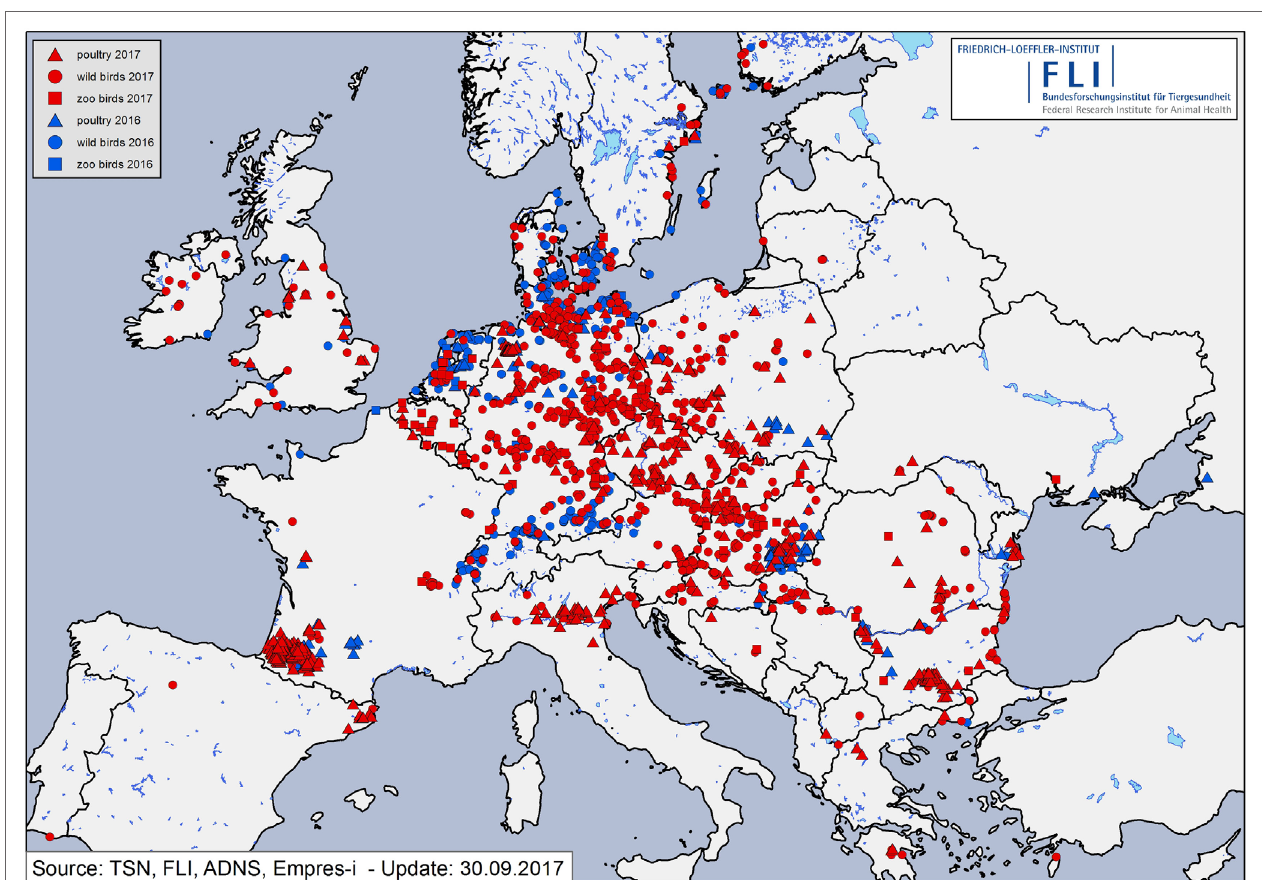
FigUre 2 | Distribution of reported highly pathogenic avian influenza clade 2.3.4.4b H5Nx cases in wild birds (points) and outbreaks in poultry holdings (triangles) and captive birds in zoos (squares) in 2016 (blue) and 2017 (red) in